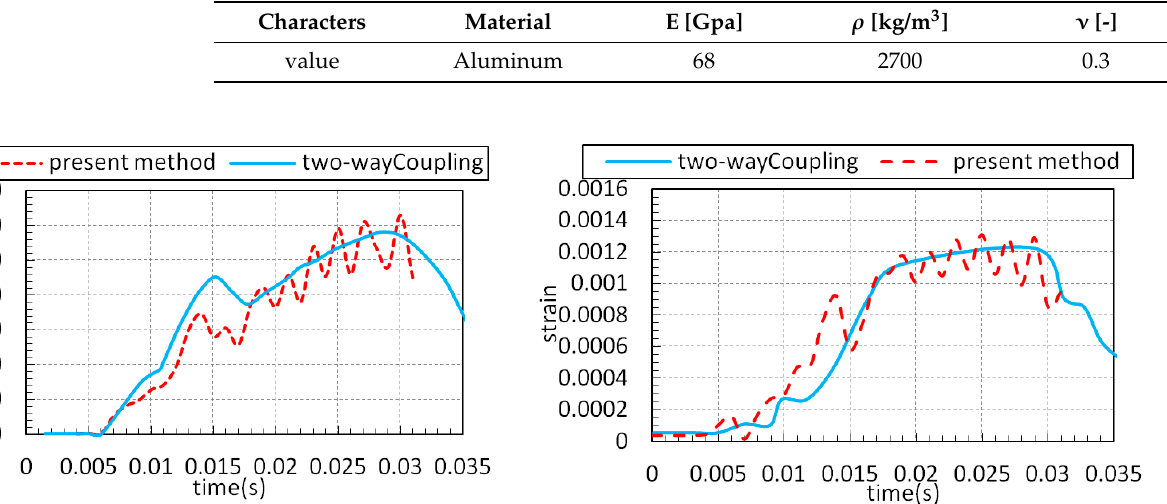
Figure 7. Present method (by considering the wedge impact) verification versus two-way coupling [24]. Table 7. Wedge characteristic used for one-way coupling verification solution.